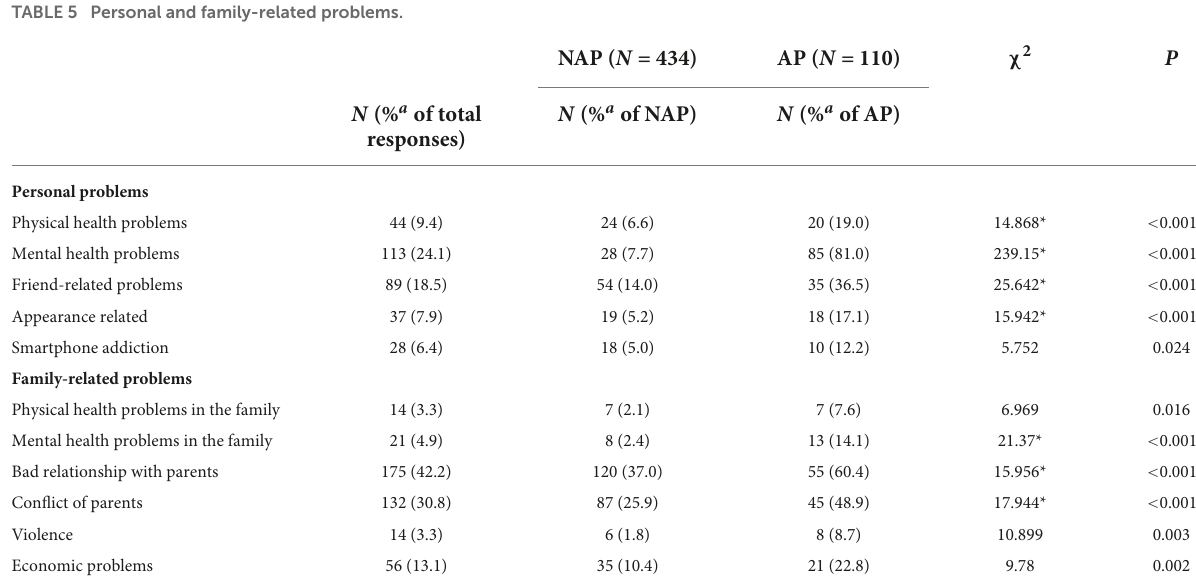
TABLE 5 Personal and family-related